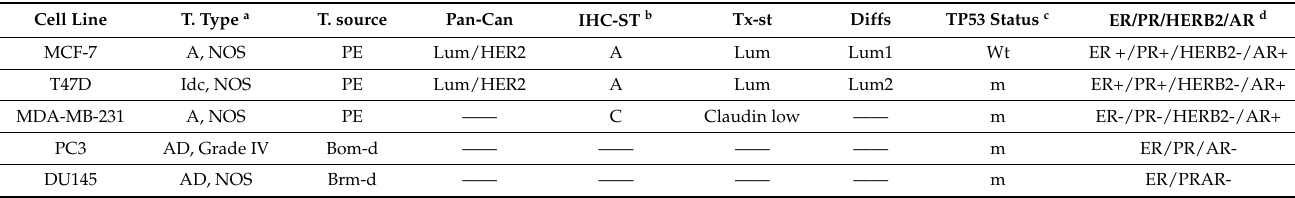
Table 3. Characteristics of cancer cell